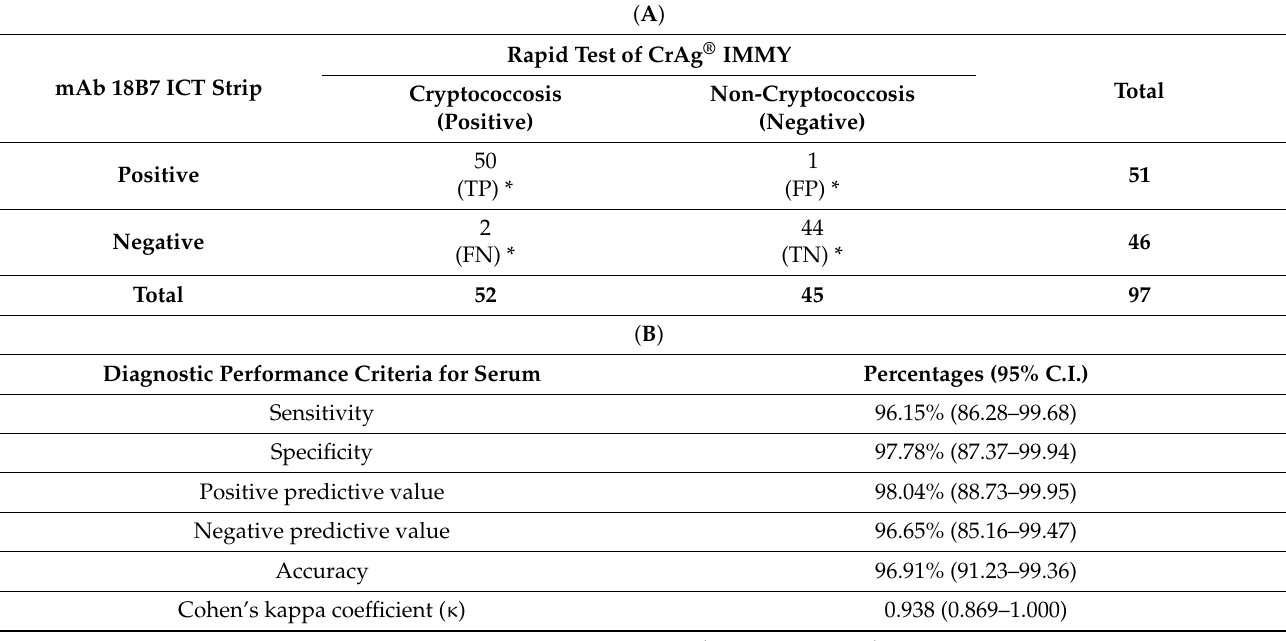
Table 4. ( A ) Two by Two table for diagnostic performance of mAb 18B7 ICT strip against serum samples compared with the rapid test of CrAg ® IMMY; ( B ) Summary of diagnostic performance of mAb 18B7 ICT strip with serum